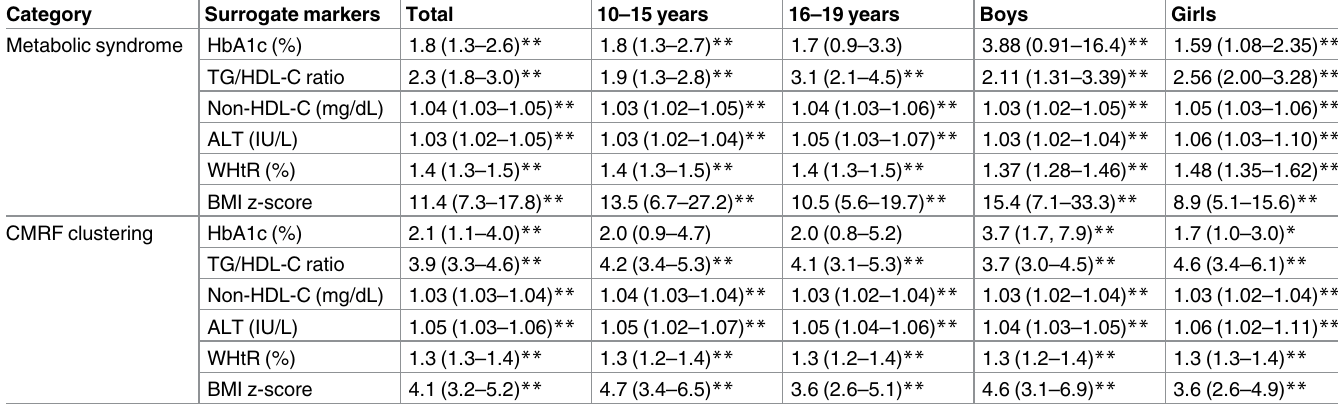
Table 2. Age- and sex-adjusted odds ratios (95% confidence intervals) of surrogate markerspredicting metabolic syndrome and cardiometabolic risk factor (CMRF) clustering. Category Surrogate markers